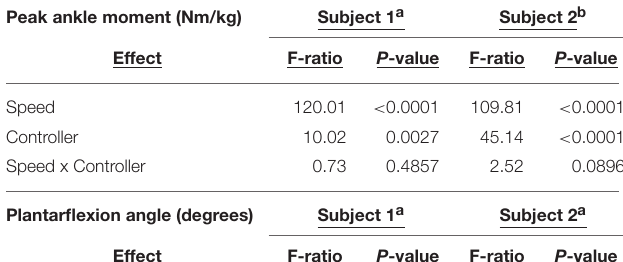
than with the stock controller at the faster speeds. Subject 2 had the lowest cost of transport when using the WFH-controller at the slow and intermediate speeds, but the stock controller had the lowest cost of transport at the fastest speed ( Figure 4